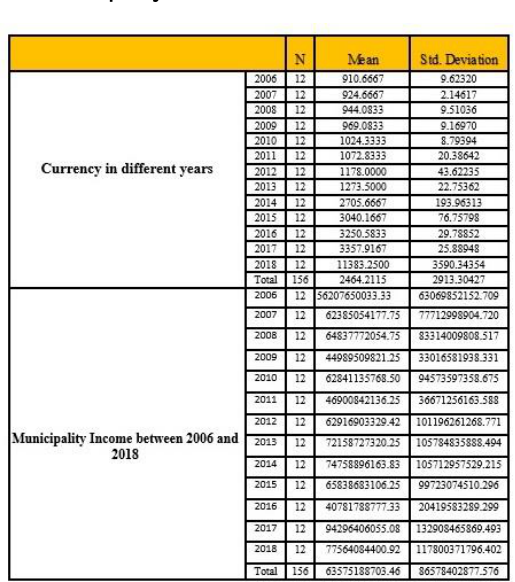
Table 1: Status of Sanandaj Currency and Municipality Revenue between 2006 and 2018